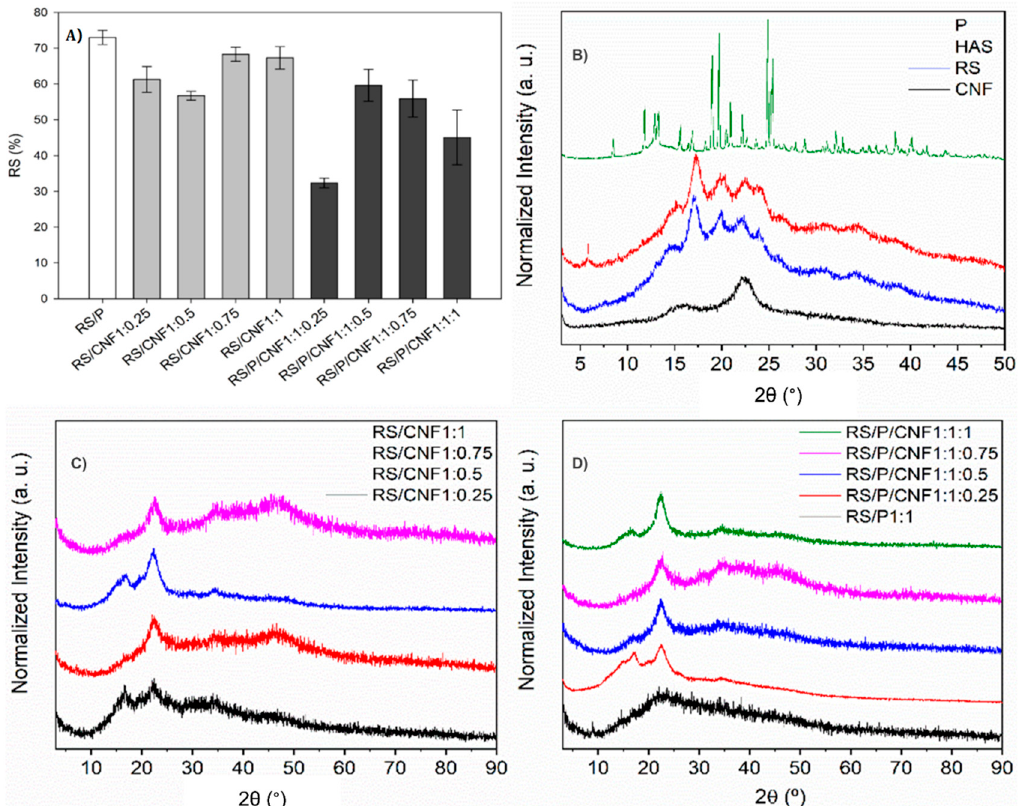
Figure 1. RS content (%) as a function of the different proportions of pectin and/or CNF after incubation with an enzymatic solution of pancreatin (0.15 g mL − 1 ). RS quantification was performed through the DNS method for reducing sugar ( A ). X-ray diffractogram patterns of isolated polymers (P, HAS, RS and CNF) ( B ), RS in distinct proportions of CNF (RS/CNF1:1, RS/CNF1:0.75, RS/CNF1:0.5 and RS/CNF1:0.25) ( C ) and RS in the presence of P and distinct proportions of CNF (RS/P/CNF1:1:1, RS/P/CNF1:1:0.75, RS/P/CNF1:1:0.5, RS/P/CNF1:1:0.25) ( D ).